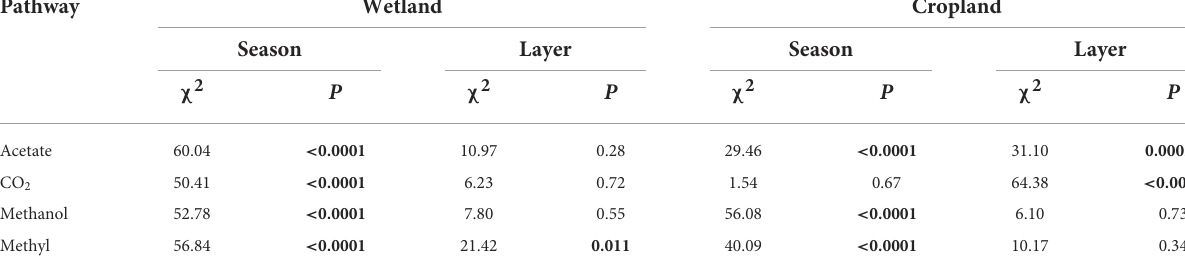
TABLE 2 The Kruskal–Wallis test of four methane production pathways’ percentage. Pathway